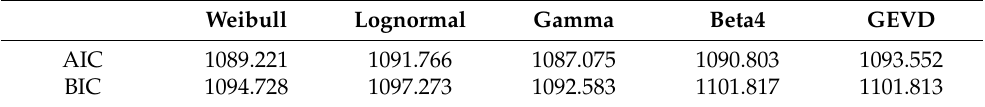
Table 3. AIC and BIC criteria for mean ozone level.